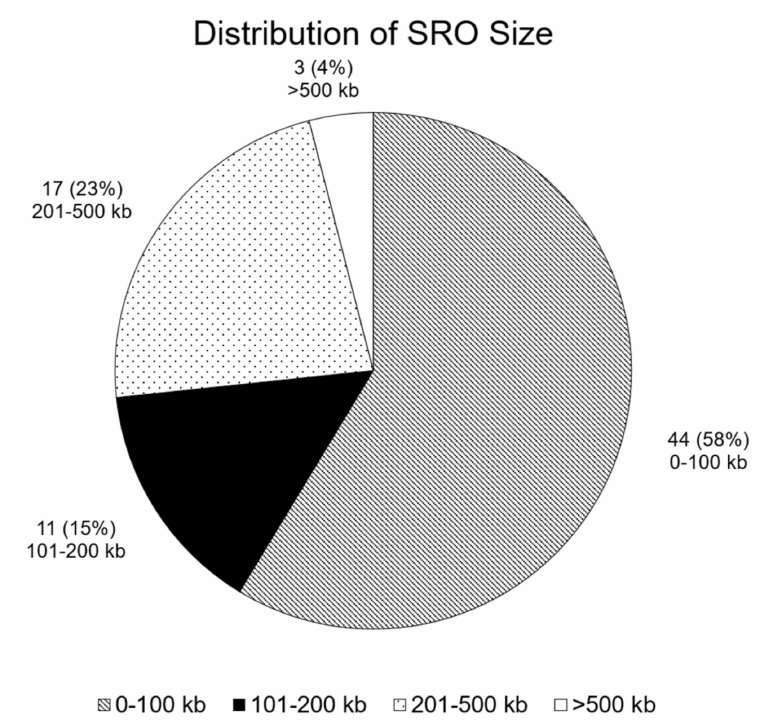
Figure 1. Distribution of SRO